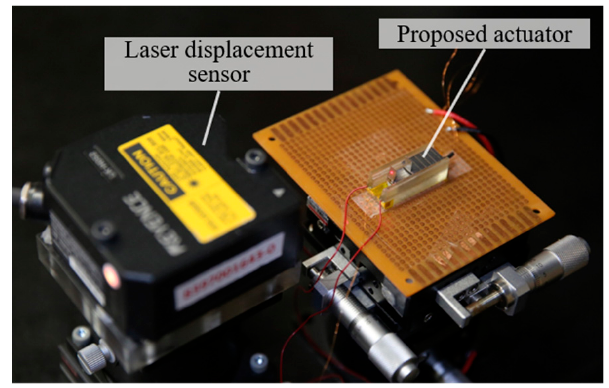
Figure 10. Experiment setup for the dual-slider driving characteristics.